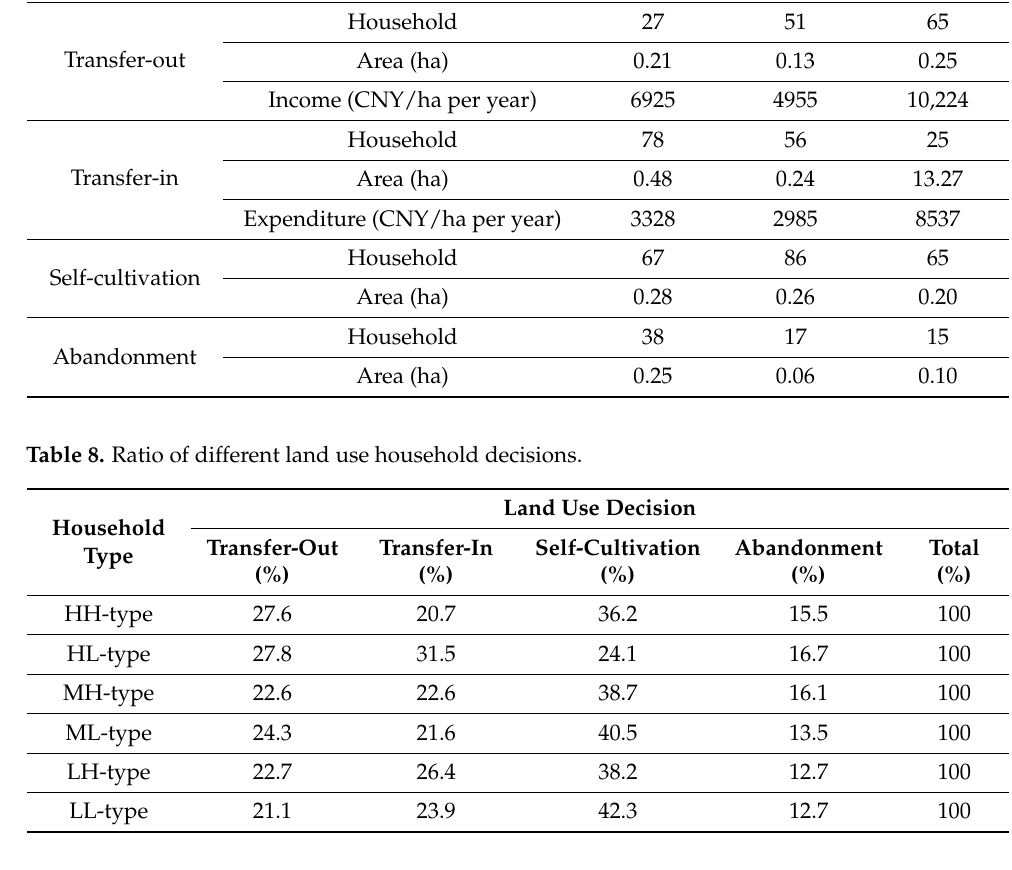
Table 7. Land use decisions by households in the different study areas. Land Use Decision